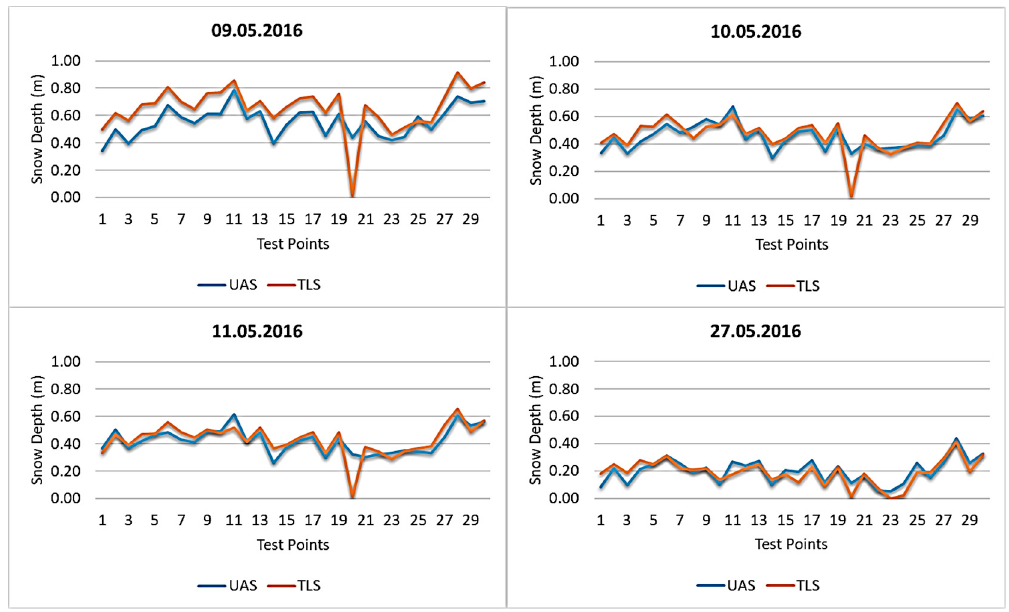
Figure 10. Comparison of UAS- and TLS-based HS values from 30 randomly distributed test points, which were also used for an independent t -test, over snow-covered areas during all time periods.